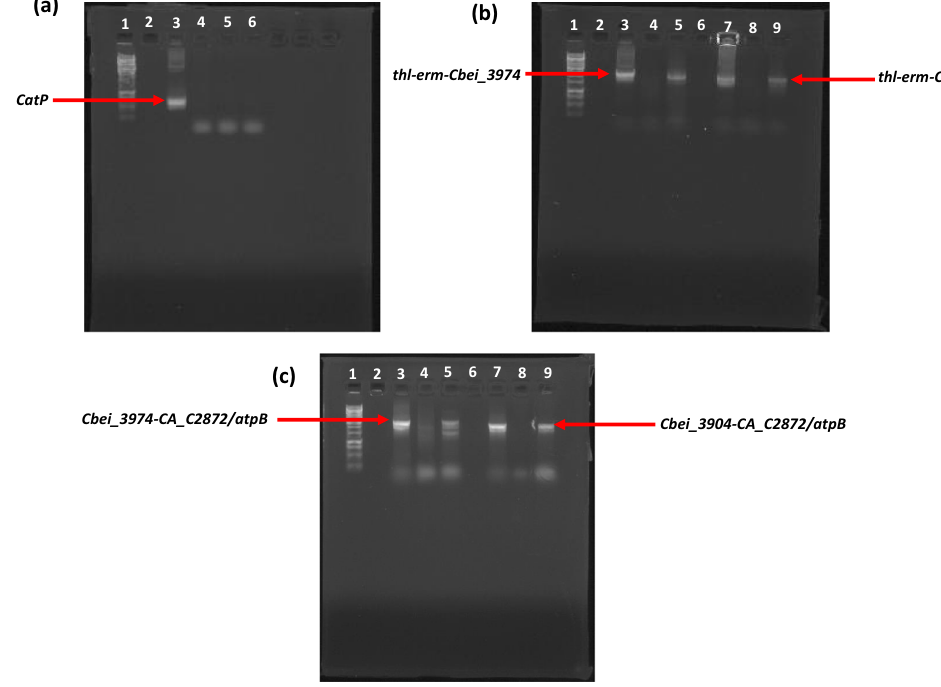
Figure 2. PCR amplification capturing the flanking regions of Cbei_3974 and Cbei_3904 following genomic integration, using gDNA from plasmid-cured Cb _3974 and Cb _3904 as templates. ( a ) Gel image showing CatP amplicon following PCR with CatP -gene specific primers. Lane 1: 1 kb DNA ladder, lanes 3, 4, 5 and 6: pMTL-JH16, gDNA from Cb _wildtype, Cb _3974 and Cb _3904, respectively. ( b ) Amplicons resulting from PCR amplification (step 1) of the flanking regions of chromosomally integrated Cbei_3974 and Cbei_3904 ( thl - erm - Cbei_ 3974/ Cbei_3904 . DNA ladder (lane 1), pMTL-JH16_3974 (lane 3), Cb _wildtype (lane 4), Cb _3974 (lane 5), pMTL-JH16_3904 (lane 7), Cb _wild type (lane 8), Cb _3904 (lane 9). ( c ) Amplicons resulting from PCR amplification (step 2) of the flanking regions of chromosomally integrated Cbei_3974 and Cbei_3904 ( Cbei_ 3974/ Cbei_ 3904- CA_C 2872/ atpB ). DNA ladder (lane 1), pMTL-JH16_3974 (lane 3), Cb _wild type (lane 4), Cb _3974 (lane 5), pMTL-JH16_3904 (lane 7), Cb _wild type (lane 8), Cb _3904 (lane 9). The gel images were cropped for clarity and the full-length gels are presented in Fig.